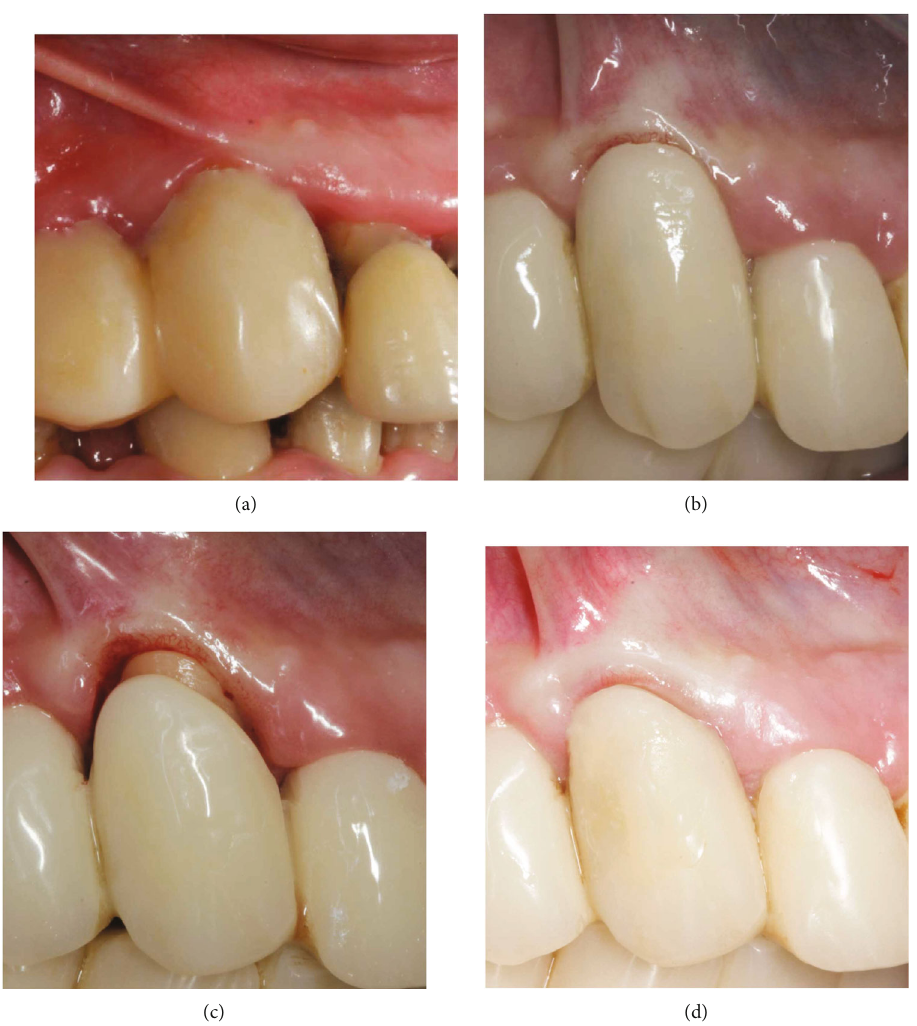
Figure 2: Adaptation of the soft tissue after the feather-edge preparation: (a) old complete crown restorations; (b) new interim restoration with the BOPT protocol; (c) right canine shortened after BOPT; (d) coronal growth of the gingiva after one month.